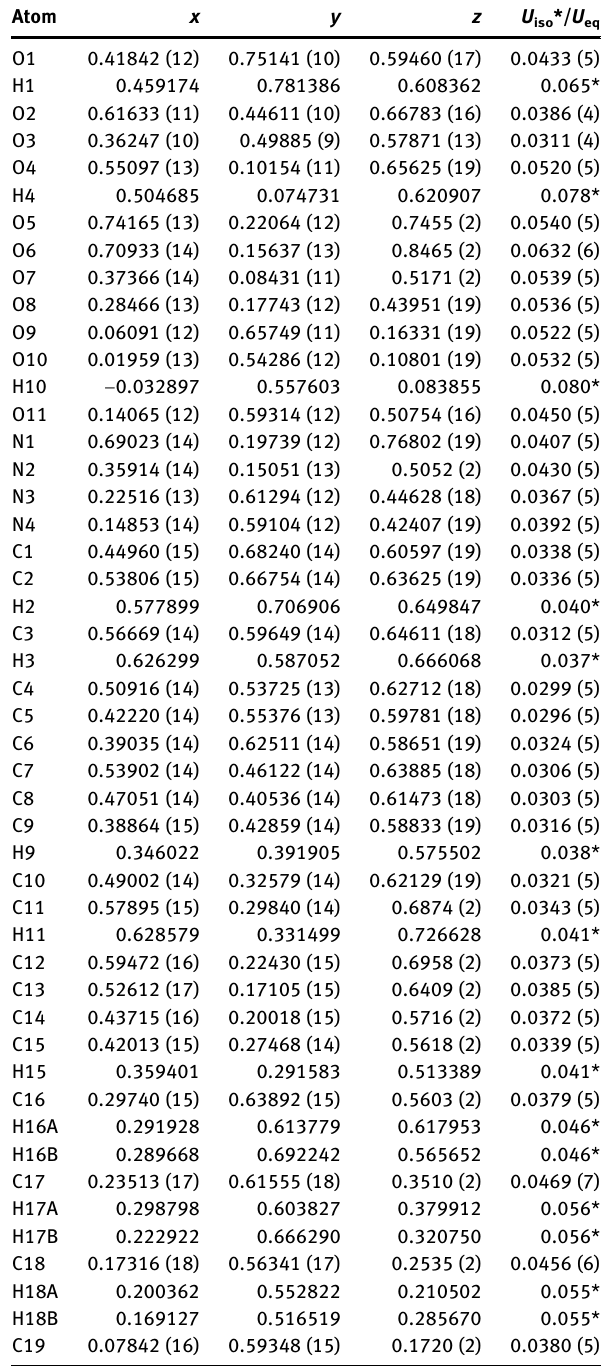
Table  : Fractional atomic coordinates and isotropic or equivalent isotropic displacement parameters (Å 